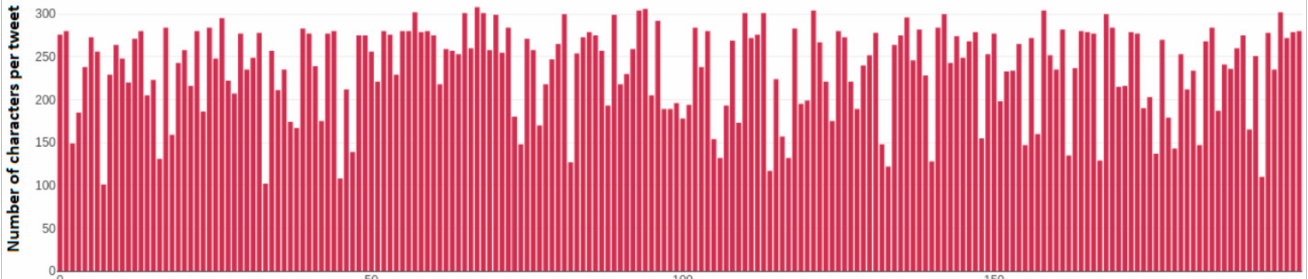
Figure 12. Text length per tweet taken from @atsipras (200 tweet